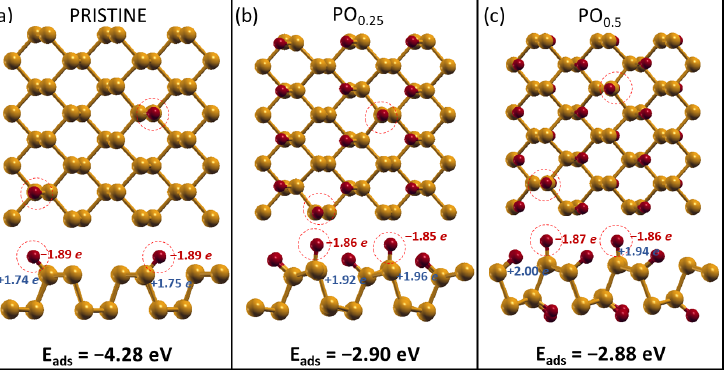
Figure 5. Oxygen dissociation on the three phosphorene substrates: ( a ) pristine phosphorene and oxidized phosphorene with an oxygen coverage of, respectively, ( b ) 25% and ( c ) 50%. Above, the top view is shown, while below, the lateral views are reported. Partial charges on atoms are displayed, together with the three adsorption